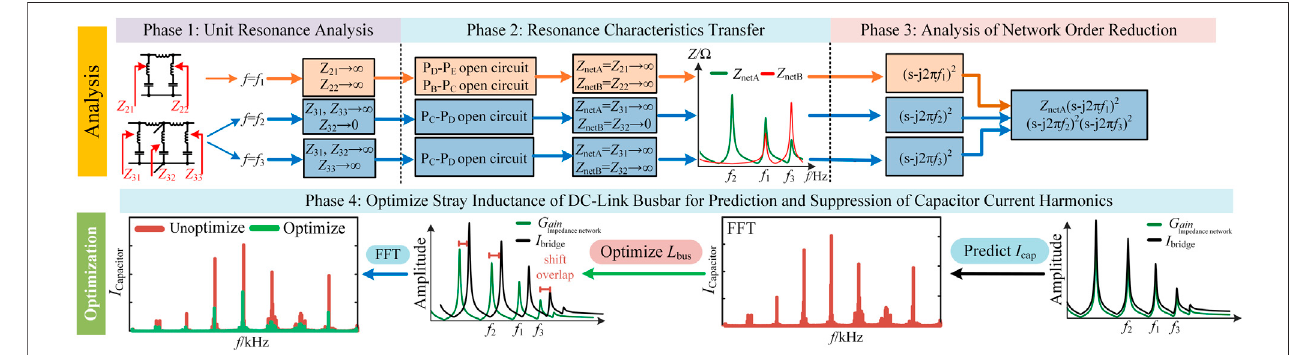
FIGURE 3 | Analysis process for busbar impedance network resonance